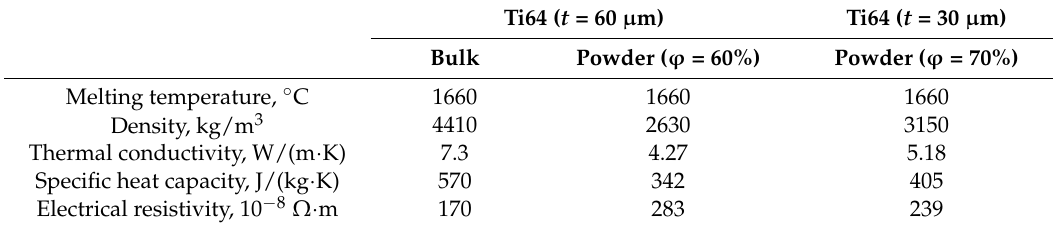
Figure 6. Processing maps for Ti64 alloy for layer thicknesses of ( a ) 60 µ m and ( b ) 30 µ m (EOS M 280). Table 4. Physical properties of Ti64 powders used for melt pool modeling [26,34]. The experimentally measured densities of Ti64 coupons printed with the layer thicknesses of t = 60 m (Figure 6a) and 30 m (Figure 6b) were then superposed on the calculated processing maps (these coupons were printed using EOS Ti64 powder and the EOS M280 system of this study). The mean porosity deviations for t = 60 m corresponded to 0.8%, while for t = 30 m, it was 0.4%.